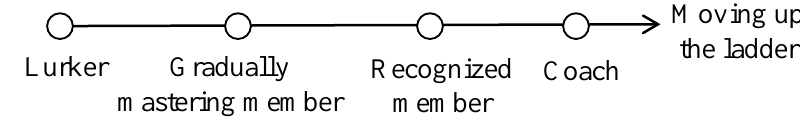
Figure 1. The investigated research scale based on the “ladder of participation and